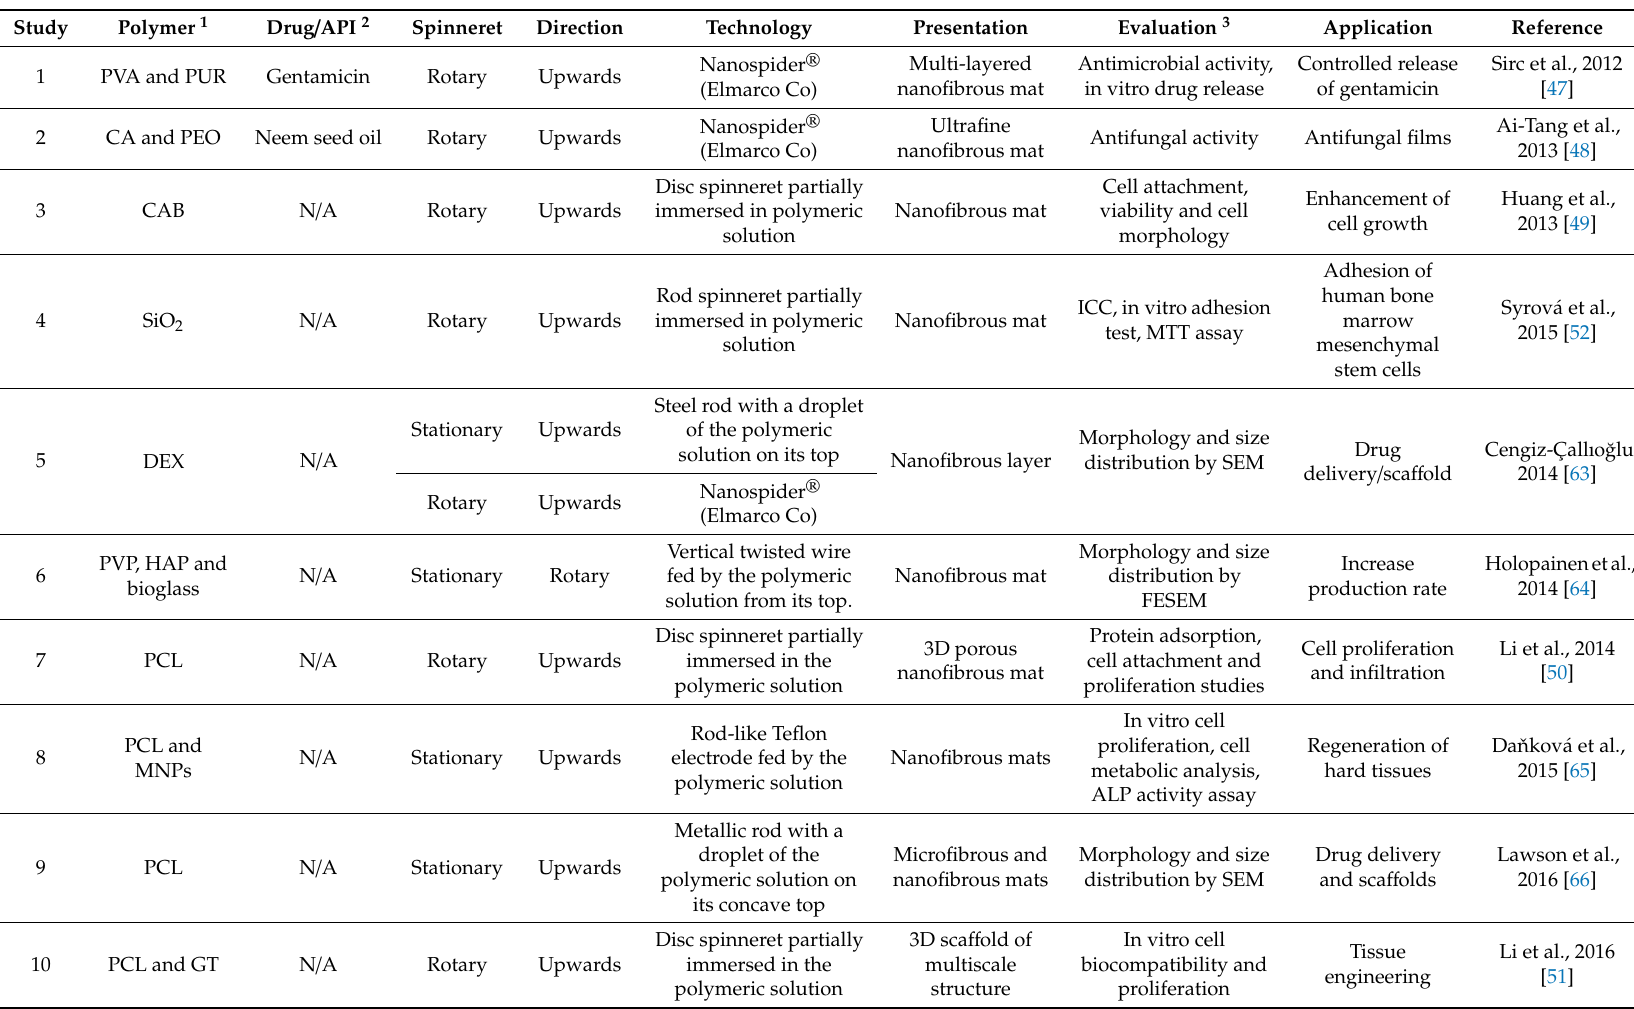
Table 1. Studies on needleless electrospinning (NLES) for the fabrication of nanofibers aimed at biomedical or pharmaceutical